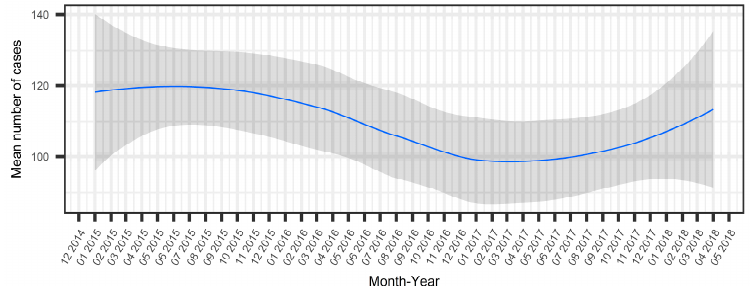
Figure 2. Loess smoothed mean and 95% CI of homicides reported by month (Inter-institutional Committee on Deaths from External Causes monthly reports).